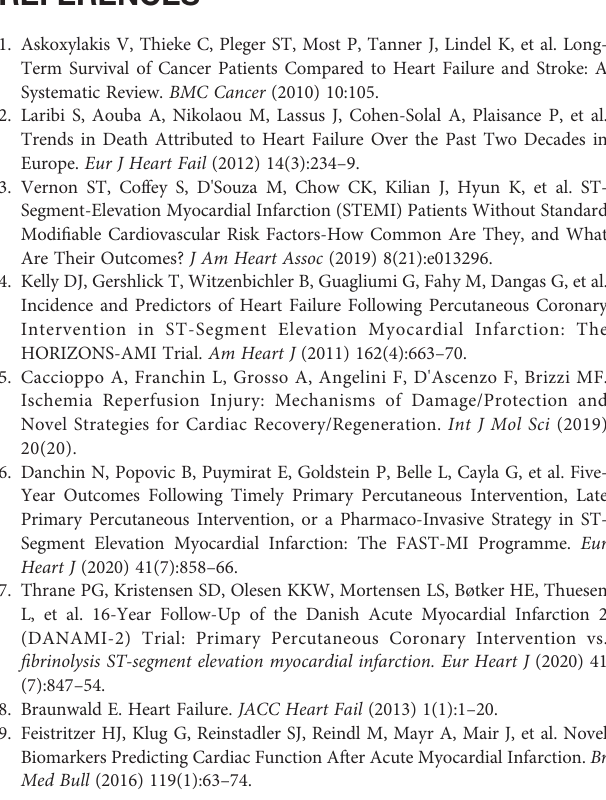
Supplementary Figure 1 | Identi fi cation of modules using WGCNA algorithm. Supplementary Figure 2 | The Clustering dendrogram of modules eigengenes and heatmaps of the correlations between eigengenes. Supplementary Figure 3 | Functional enrichment analyses of genes in greenyellow module through Metascape. Supplementary Figure 4 | Scatter plot of greenyellow module eigengenes. Supplementary Figure 5 | Analysis of scRNA seq dataset GSE135310 and cell type classi fi cation analysis. Supplementary Figure 6 | Validation of the expression levels of real hubgenes of Niu ’ s study in post-AMI HF and post-AMI non-HF patients based on datasets GSE11947 and